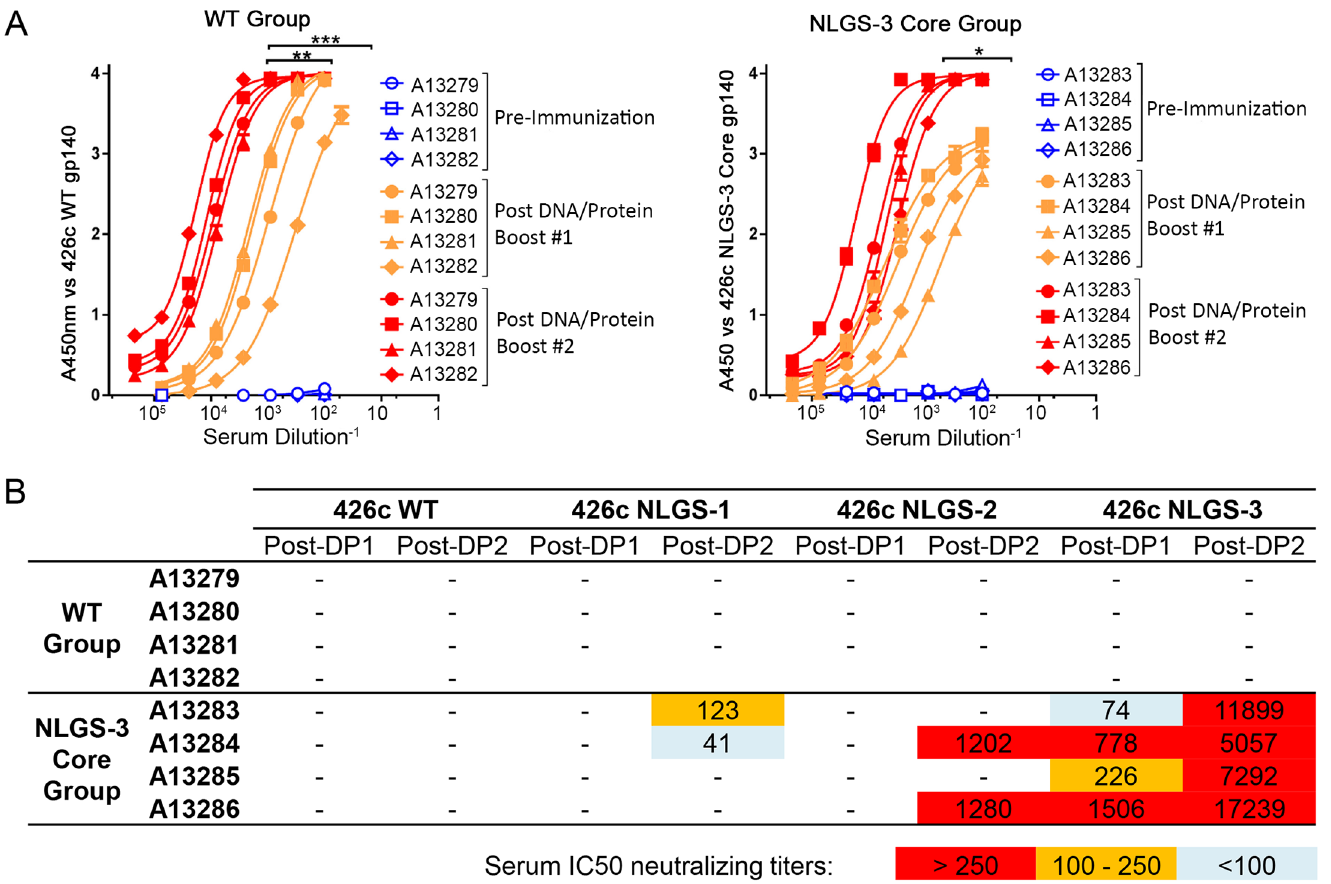
Fig 1. Binding and neutralizing serum activities. (A) Sera collected from the WT (left) and NLGS-3 Core (right) prior to immunization (blue) , following the DNA/ Protein Boost 1 (orange) , and following the DNA/Protein Boost 2 (red) were tested for antibody reactivity to autologous rEnv immunogens. (cid:3) indicates p value < 0 . 01 , (cid:3)(cid:3) p value < 0 . 001 ,or (cid:3)(cid:3)(cid:3) p value < 0 . 0001 .(B) Reciprocal IC50 serum neutralization titers following the DNA/Protein Boost 1 immunization (Post-DP1) and the Post DNA/Protein Boost 2 immunization (Post-DP2). Neutralizing activities were determined against viruses expressing WT 426c envelope and 426c envelope NLGS variants with mutations in Loop D and V5. NLGS-1 lacks the NLGS at position 276 in Loop D, NLGS-2 lacks two NLGS in V5 at positions 460 and 463, while NLGS-3 lacks all three NLGS. https://doi.org/10.1371/journal.ppat.1007120.g001 4/4 animals generated anti-NLGS-3 neutralizing antibody responses, only 2/4 animals